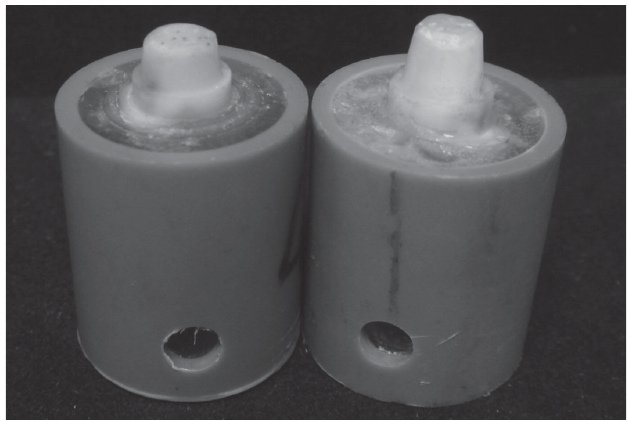
Fig. 2 – Preparation heights: 3 mm (left) and 5 mm